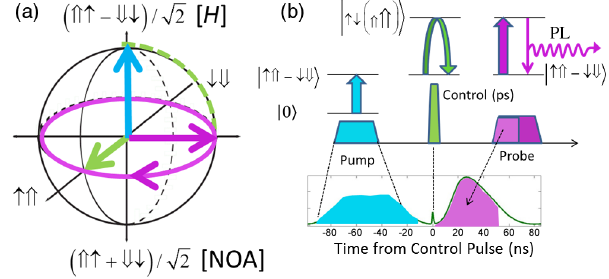
FIG. 6. (a) Schematic description of the precession of the DE on the Bloch sphere. The pump π pulse [blue arrow, Fig. 3(b)] deterministically generates the DE in its lower-energy eigenstate (north pole of the sphere). The positively detuned circularly polarized control 2 π pulse [green arrow, Fig. 3(c)] “ rotates ” the DE by an angle of π = 2 about the polarization direction (green arrow) and brings the DE within the pulse duration (few pico- seconds) to the equatorial plane of the Bloch sphere (dashed green line). The DE then precesses clockwise in time as described by the magenta trajectory on the Bloch sphere. The optical activity of the DE eigenstates ([ H ] for H polarized and [NOA] for no optical activity) is shown to the right of the spin configuration. (b) Schematic description of the pulse sequence used in this experiment. A resonant DE π pulse [blue arrow, Fig. 3(b)] is used to deterministically excite the DE in the [ H ] eigenstate. Then, a properly detuned from the biexciton resonance, circularly polar- ized, 2 π , picosecond pulse is used to rotate the DE to its j þ 2 i coherent spin state. A long polarized probe pulse (magenta) is then used to probe the DE precession, which gives rise to temporal oscillations in the circular polarization of the emitted light from the biexciton transition [Fig. 3(d)]. The actual measured temporal sequence of pulses is shown below the schematic